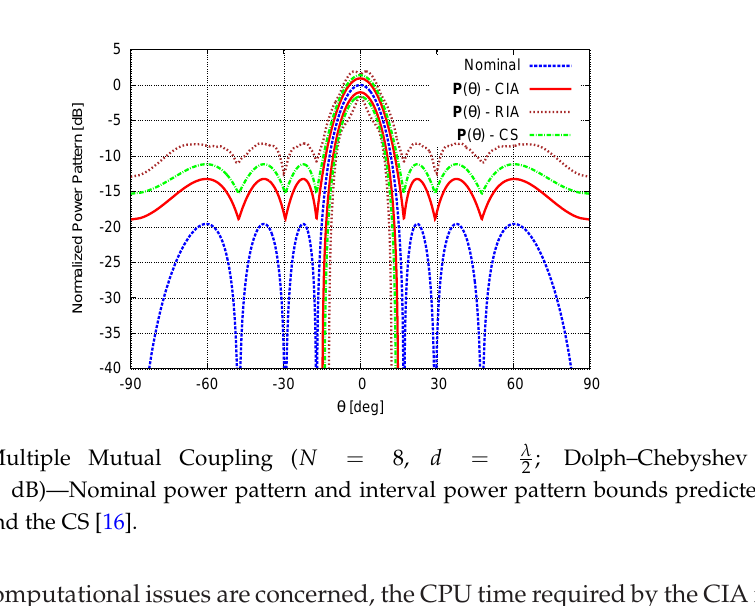
; Dolph–Chebyshev pattern: 2